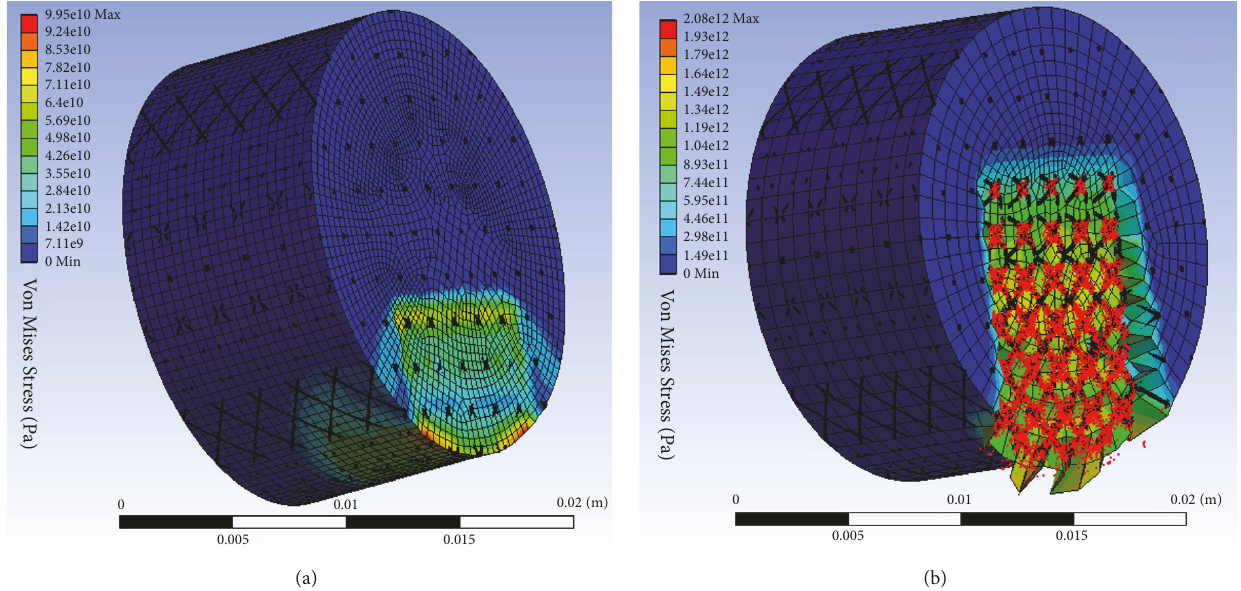
Figure 12: Stresses resulting from impact simulation of sample consisting of diamond and Ti6Al4V lattice structure: (a) 1000 J and (b) 5000 J impact energy.